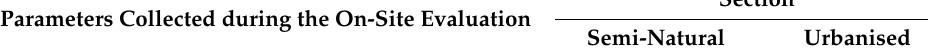
Table 4. Components of the Hydromorphological Diversity Score (HDS) and the Hydromorphology Modification Score (HMS).